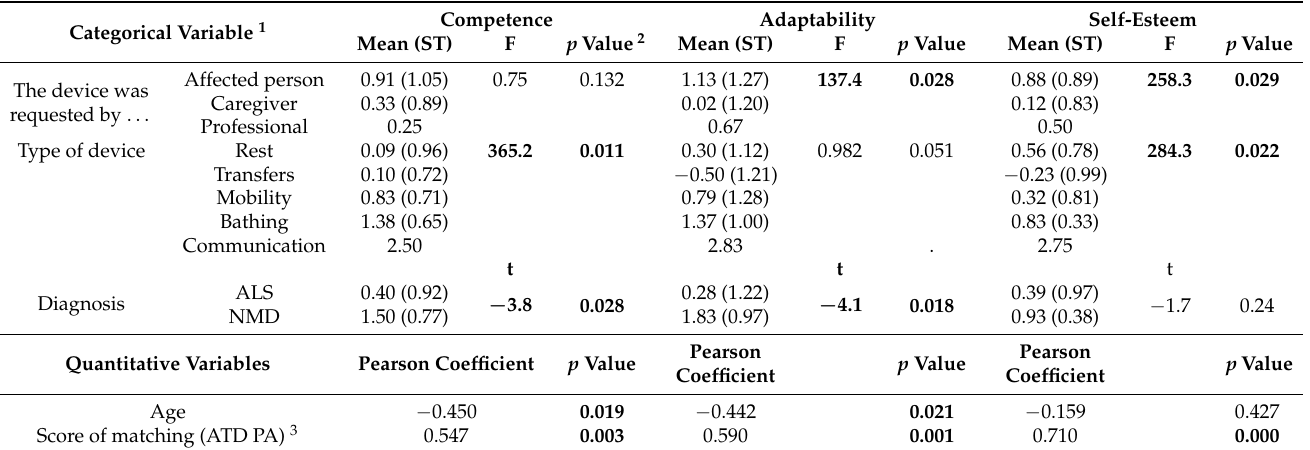
Table 3. Variables with significant influence on dimensions of the